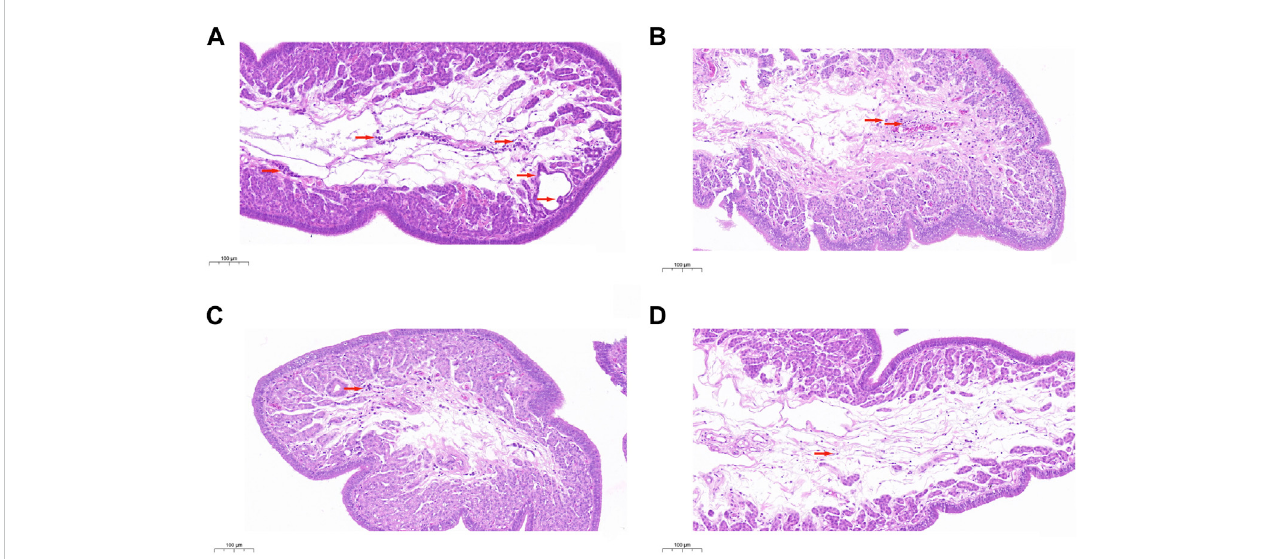
FIGURE 1 Tissues from the uterus were removed and stained with H&E. Scale bar: 100 μ m. (A) Uterine histopathology in the control group; (B – D) Uterine histopathology with PCHM treatment groups at 0%, 0.2%, 0.4%, and 0.8%, respectively. The locations of tissue damage and in fl ammatory cell in fi ltration are denoted by the directional arrows in red.